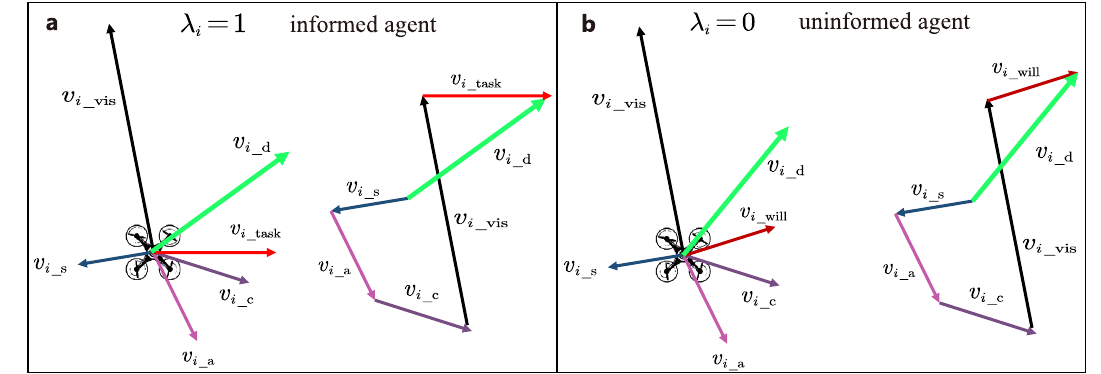
Fig.1 Schematicdiagramofthedesiredvelocity v i _d . a Thevelocitycomponentoftheinformedagent. b Thevelocitycomponentoftheuninformed agent